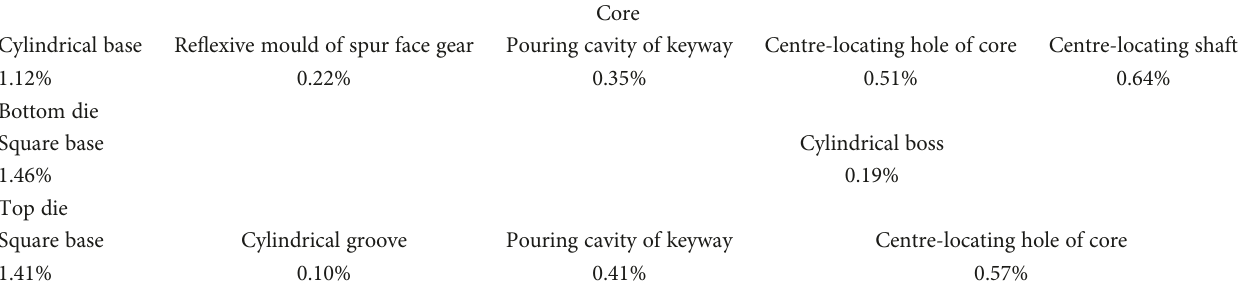
Table 2: The shrinkage percentage of each spur face gear master